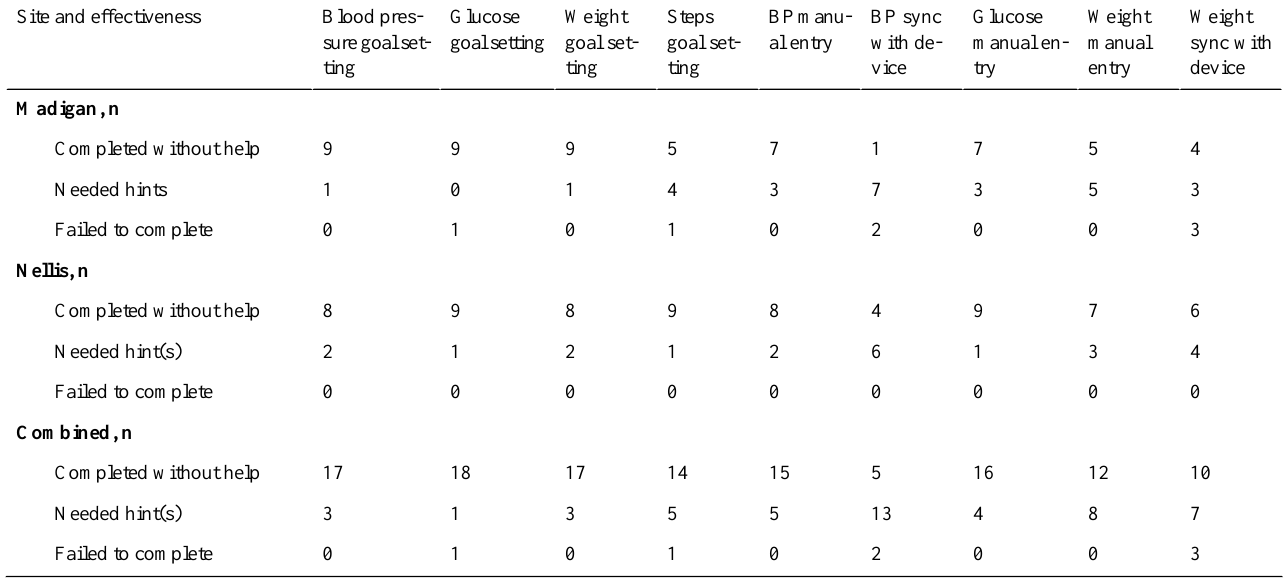
Table 1. Phase I participant effectiveness with the technology. Here, n denotes the number of responses in each